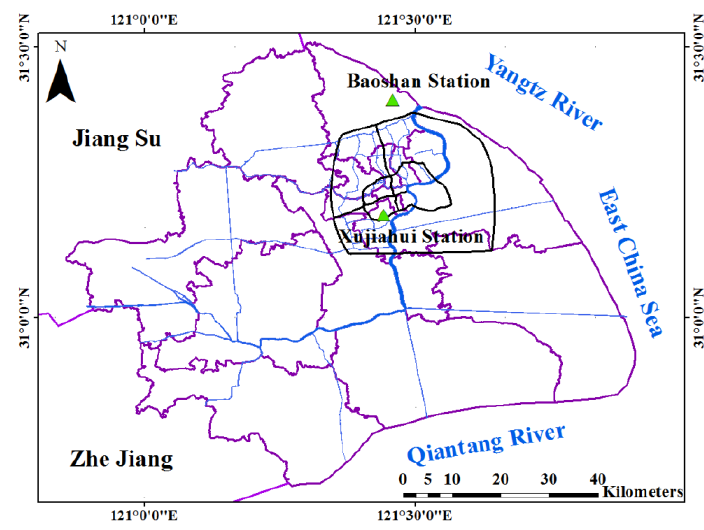
Figure 1 . The location of Xujiahui and Baoshan meteorological station. Figure 1. The location of Xujiahui and Baoshan meteorological